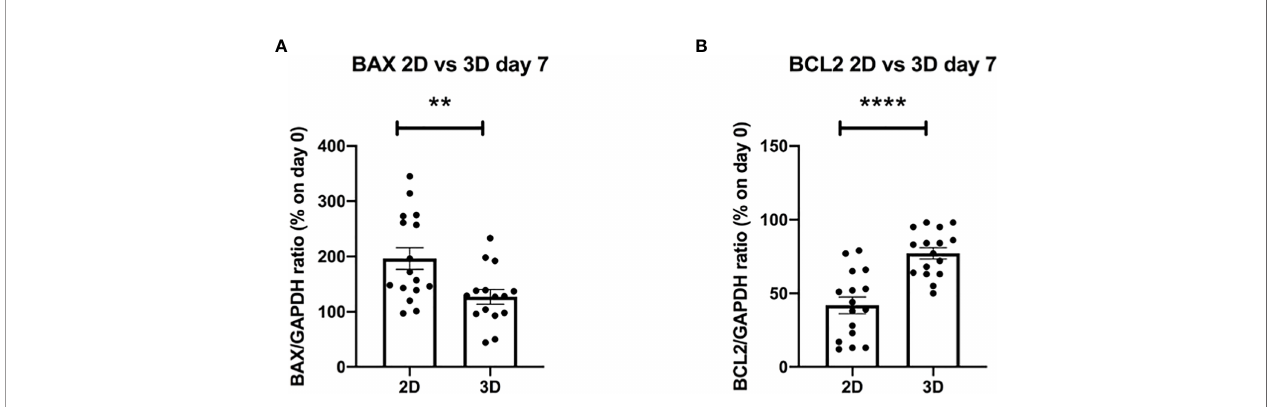
FIGURE 8 | The evaluation of apoptotic genes shows better survival of 3D bioprinted primary cells compared to 2D cultured ones at the same time of culture. (A, B) The graphs show mRNA levels of pro-apoptotic gene BAX and anti-apoptotic gene BCL2 , after 7 days of culture, of 3D bioprinted CLL primary cells compared to CLL primary cells cultured in the traditional 2D system. **p < 0.01, ****p < 0.0001. Data are represented as mean ± SEM, n = 16 patient samples. Mann-Whitney t-test was used for statistical